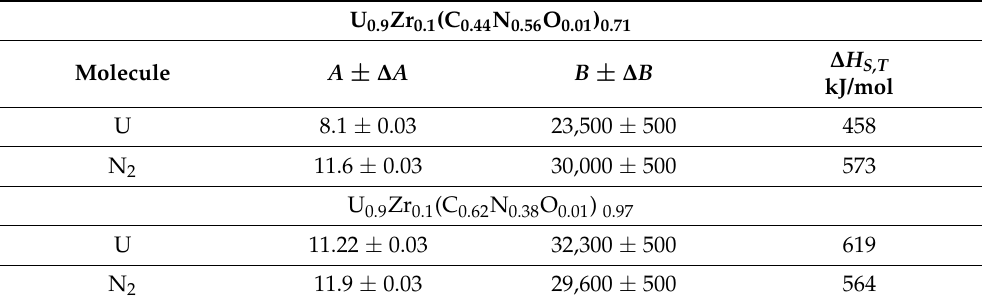
Table 4. Parameters of the temperature dependence of the partial pressures of uranium and nitrogen in the form lg P (mm Hg) = A − B/T according to [1].